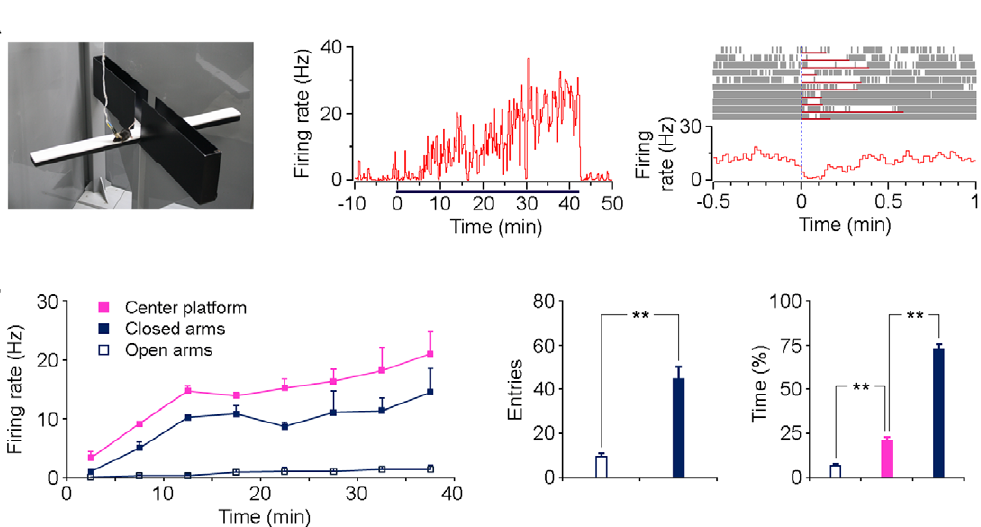
Figure 3. Activity of type-1 BLA neurons in the elevated plus-maze test. (A) Left panel, EPM test. Middle panel, rate histogram of one type-1 BLA neuron during the EPM test. Horizontal line below the histogram indicates the duration of EPM exposure. Right panel, perievent raster plot (10 trials) and perievent histogram of the same neuron referenced to the entries into the open arms. Red horizontal lines below each raster plot indicate the durations of each open-arm exploration. (B) Left panel, average firing rates of type-1 BLA neurons on open arms, closed arms and the center platform during the EPM exposure (n=4; firing rates were sampled and averaged every 5 min). Right panels, mice made significantly fewer entries into the open arms than into the closed arms (left), and spent significantly less time in open arms (right). Data in all panels are plotted as mean 6 SEM (error bars). ** P , 0.002 by t -test.